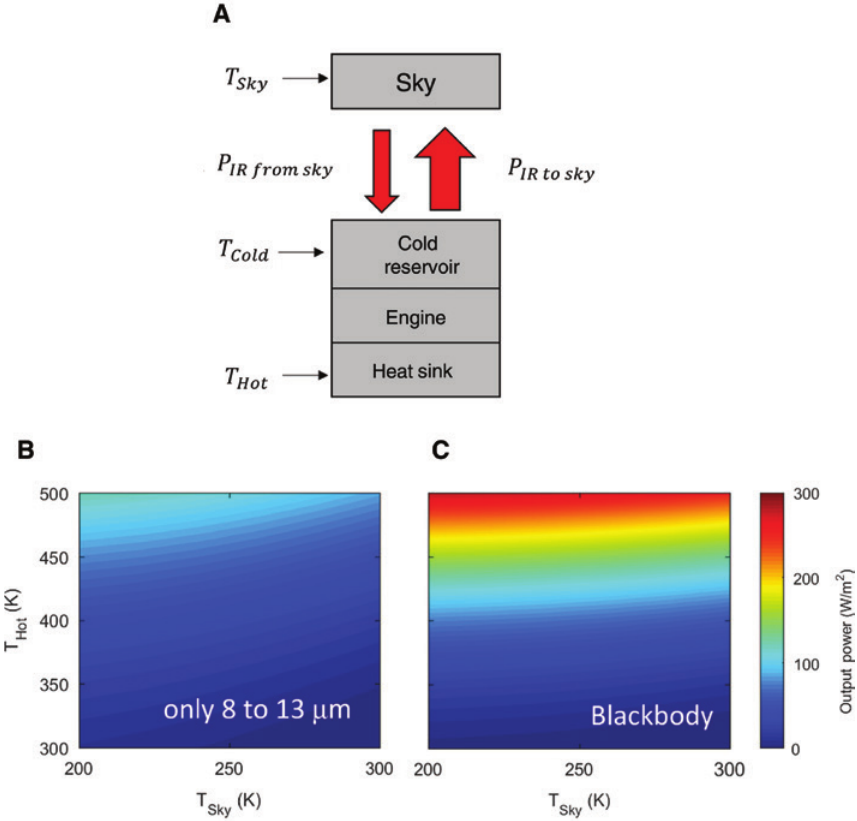
Figure 12: (A) Schematic of an EEH. Heat flows from the heat sink to the cold reservoir through the engine, which converts part of the heat into useable energy; the rest of the heat is radiated to the sky by the cold reservoir (or to the surroundings with non-zero emissivity outside the atmospheric window). Carnot-limited output power (W/m 2 ) of an ideal EEH that (B) only emits between 8 and 13 μ m wavelengths with a unity emissivity and (C) emits as a blackbody upwards placed outdoor at an ambient temperature of 300 K.